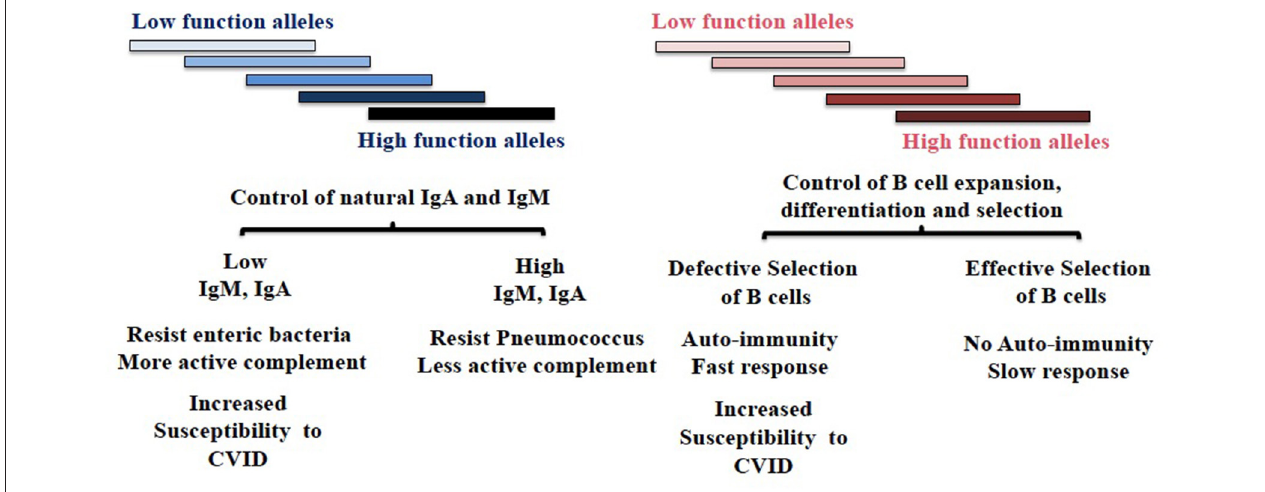
FIGURE 1 | Diversity of TNFRSF13B in host response to environmental challenges. TNFRSF13B encodes a receptor (TACI) through to support the maturation of B cells, yet the gene is among the most polymorphic in the genome and polymorphism is maintained across mammalian species. The authors speculate that polymorphism of TNFRSF13B reflects balancing selection—balancing benefits and disadvantages of signals the receptor delivers but also manifold intermediate functions the protein and its neighbors in cell membrane confer. The figure depicts two hypothetically distinct regions of the protein that confer phenotypically distinct properties. The balancing of complex sets of phenotypic properties that presumably impact all mammals could underlie extraordinary diversity of the gene across species. CVID, Common Variable